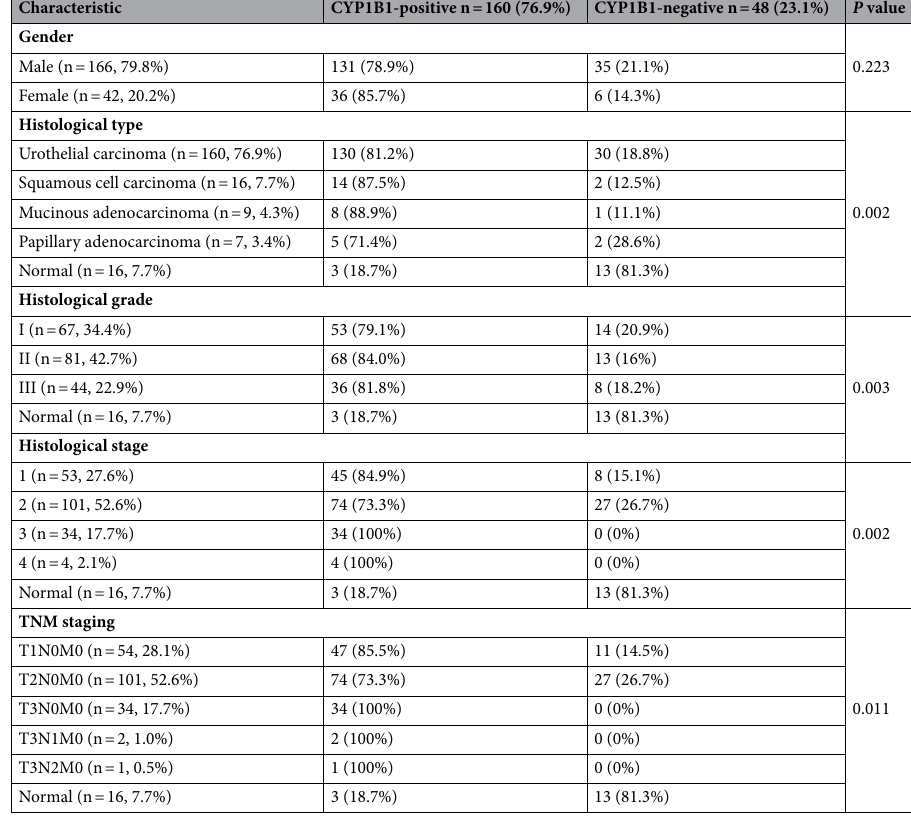
Table 2. Association between CYP1B1 expression and clinicopathologic